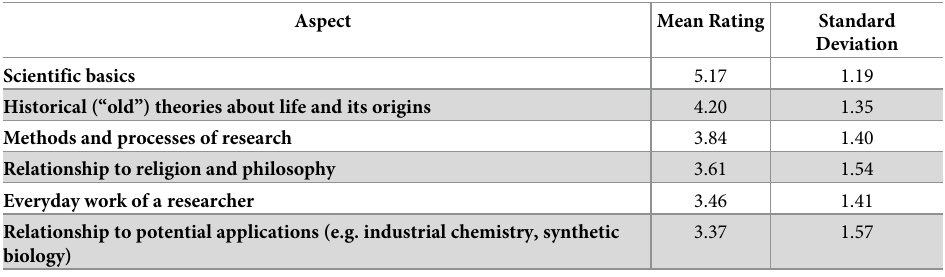
Table 2. Importance scientists gave to different aspects of communication about origin of